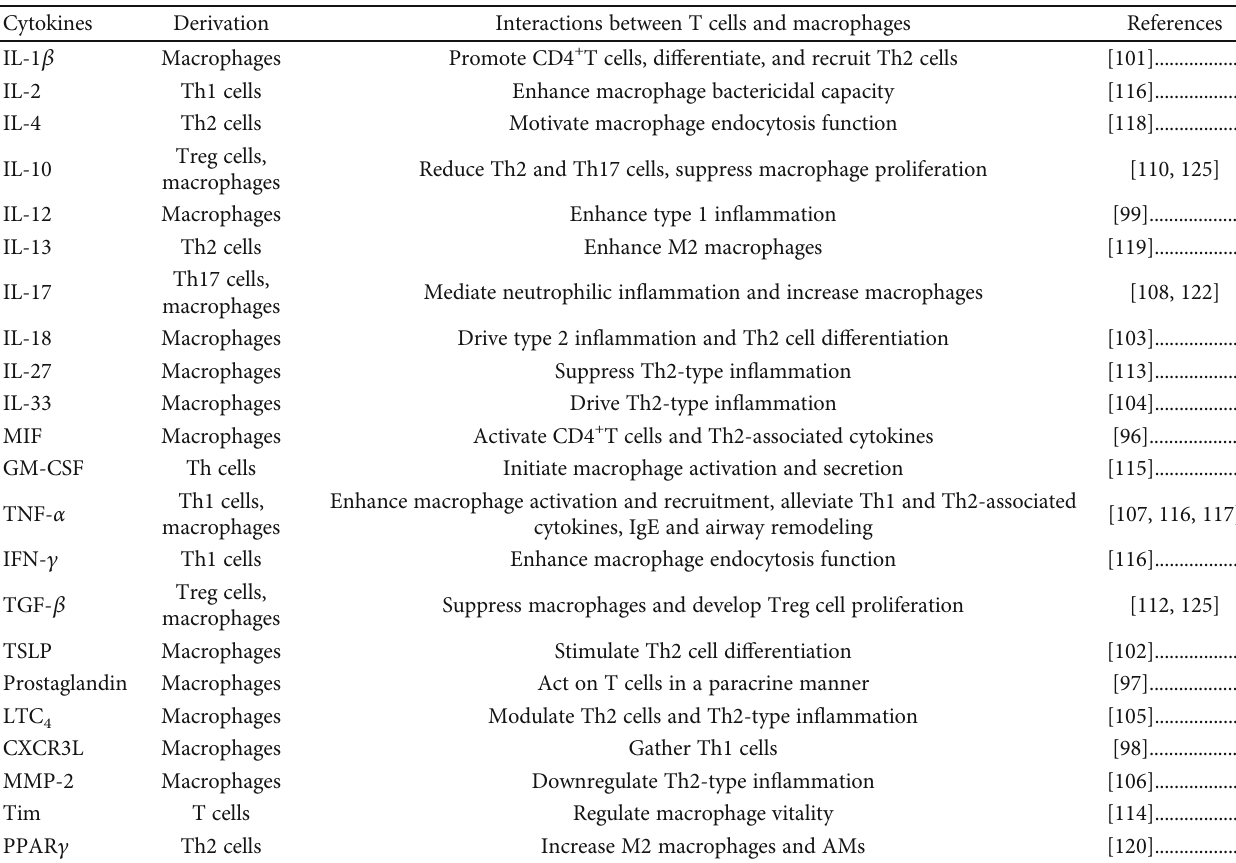
Table 1: Cytokines participating in the crosstalk between T cells and